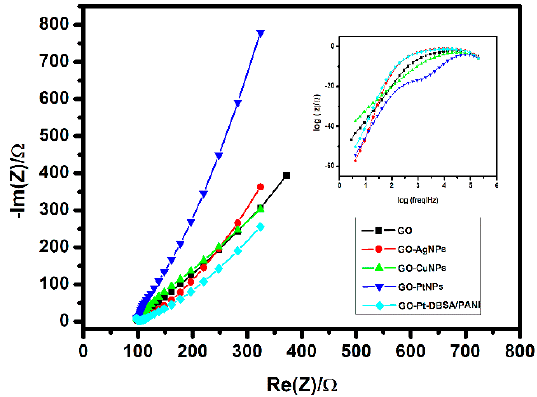
Figure 9. Electrochemical impedance spectroscopy (EIS) Nyquist plot from impedance testing of GO, GO–Ag NPs, GO–Cu NPs, GO–Pt NPs and GO–Pt–DBSA/PANI obtained in 0.1 M Na 2 SO 4 .